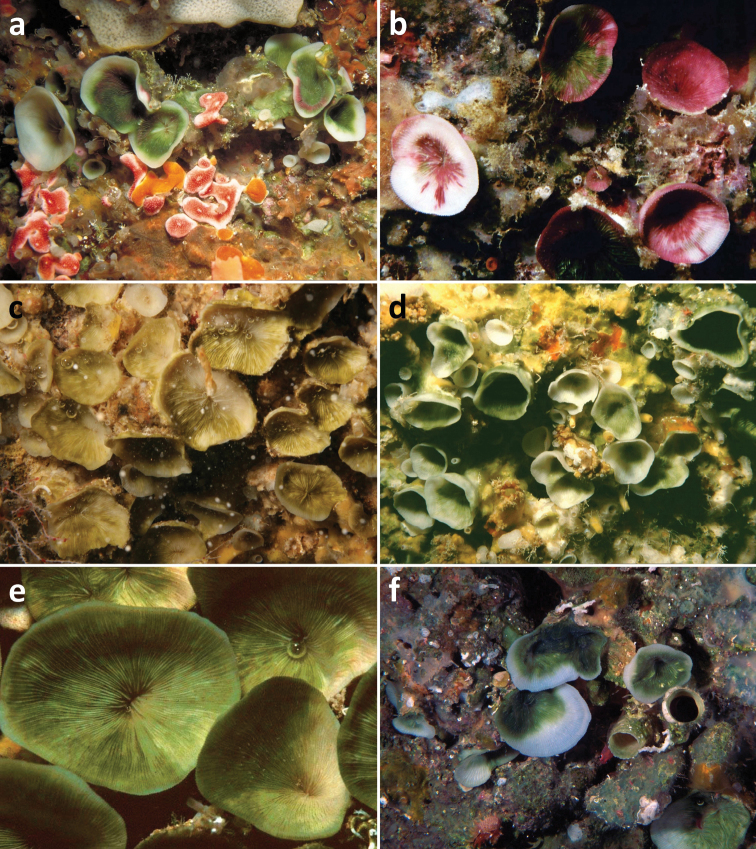
Living specimens of Leptoseris troglodyta sp. n. a Philippines, Cebu Strait, W of Bohol, NW of Cabilao Island, 10–30 m depth (7 November 1999) b Indonesia, Tukang Besi Islands (Wakatobi), Binongko, 20 m depth (10 May 2003) c Indonesia, North Sulawesi, S of Bunaken Island, 17 m depth (19 December 2008; photo B.T. Reijnen) d Palau, W of Ulong Island (Rattakadokoru Island), W off barrier reef, 32 m depth (28 July 2002) e Papua New Guinea, Misima Island, 6–10 m depth (31 May 1998; photo G. Paulay) f Guam, Blue Hole, 35 m depth (1 June 2000; photo G. Paulay).